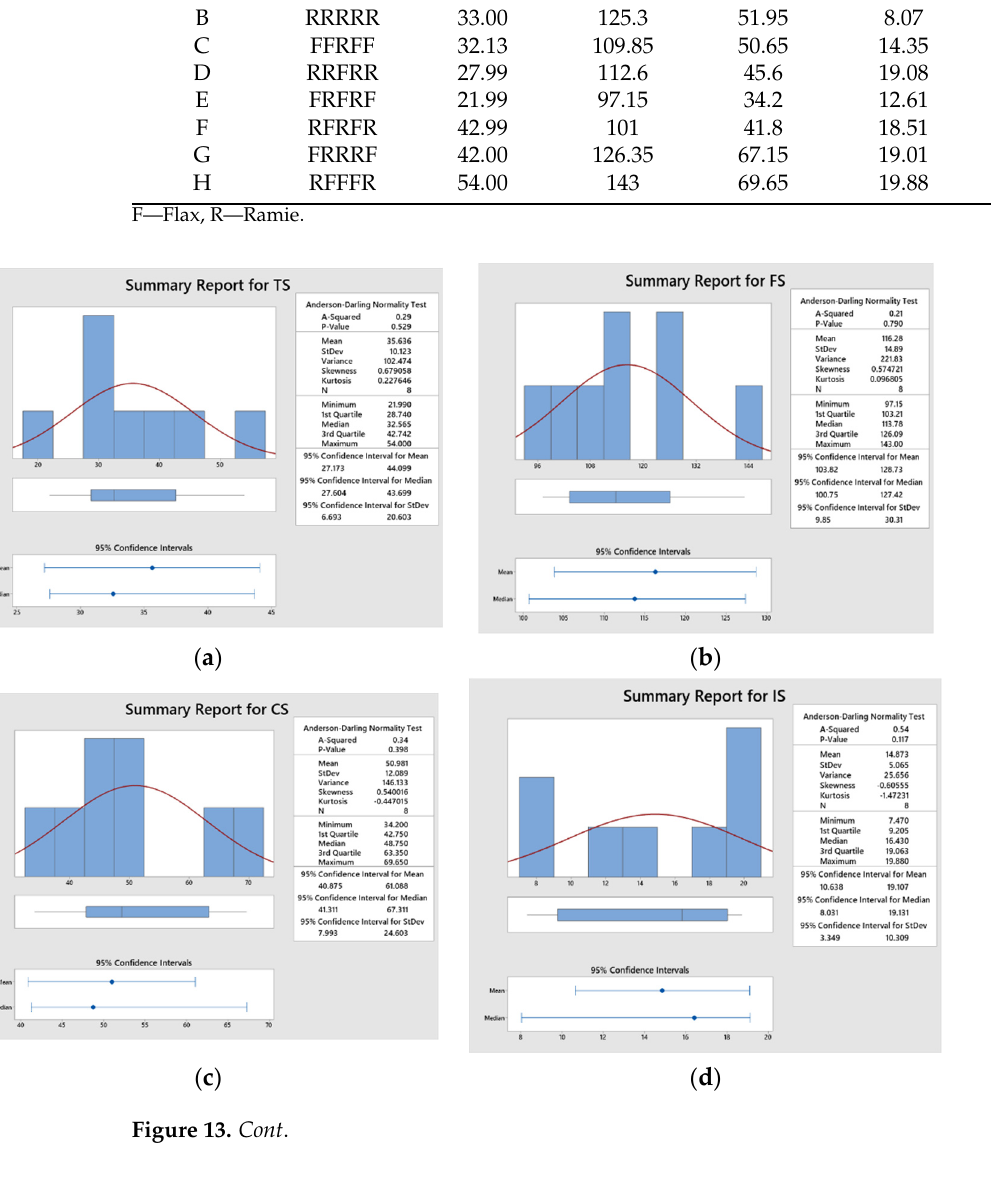
Figure 13. Statistical analysis of ( a ) tensile strength ( b ) flexural strength ( c ) compressive strength ( d ) impact strength ( e ) hardness. 3.6. Morphological Analysis The morphological analysis of ramie and flax fibre-reinforced hybrid composite at maximum condition was conducted using a scanning electron microscope. The good adhesion of fibre and resin was identified through the morphological analysis on laminate H when subjected to tensile loading. This is clearly illustrated in Figure 14a. Though the laminate was made using the vacuum infusion process there were noticeable defects such as micro voids. Due to these, some failures might have occurred. A detailed examination of the failure zone of laminate H reveals that the eventual failure was due to fibre pull-out and matrix cracking. The fibre reinforcement and the matrix were found to have good bonding. This allowed the laminate to absorb a sufficient load before failure [59,60]. The flexural test provided a detailed examination of the failure zone of laminate E. The flexural test reveals that the eventual failure was due to matrix cracking. The SEM